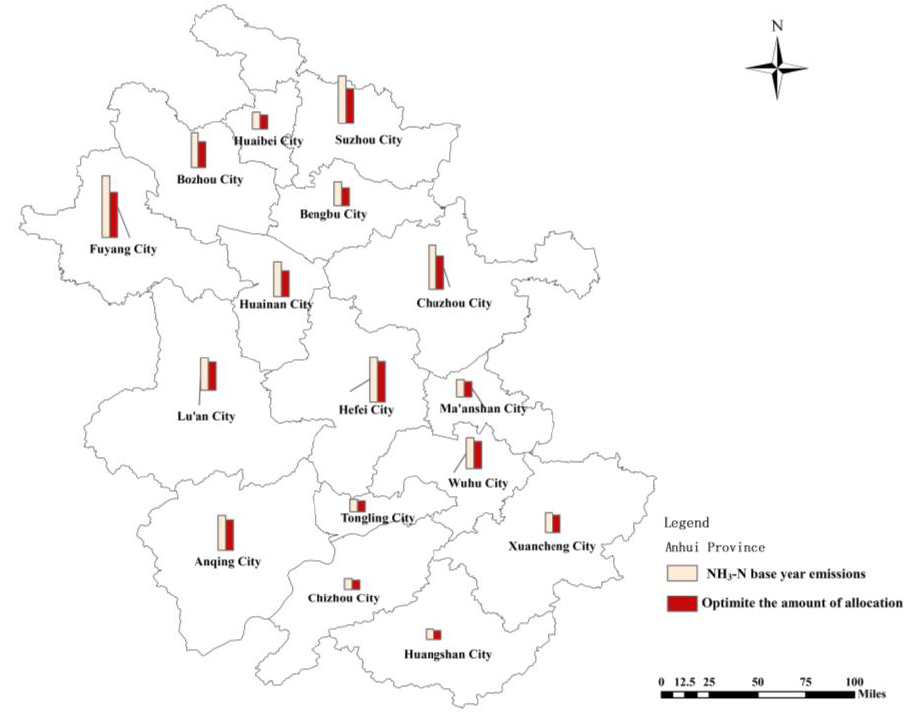
Figure 11. Comparison distribution of NH 3 -N optimized distribution results with base year.